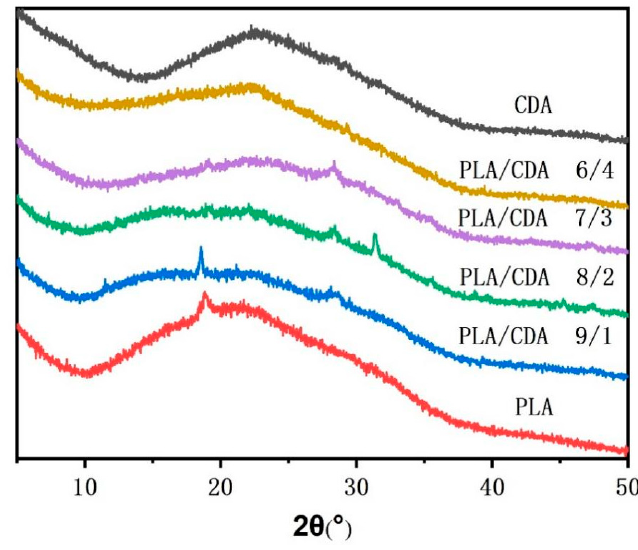
Figure 6. XRD of pure PLA, pure CDA, and PLA/CDA fiber membranes.